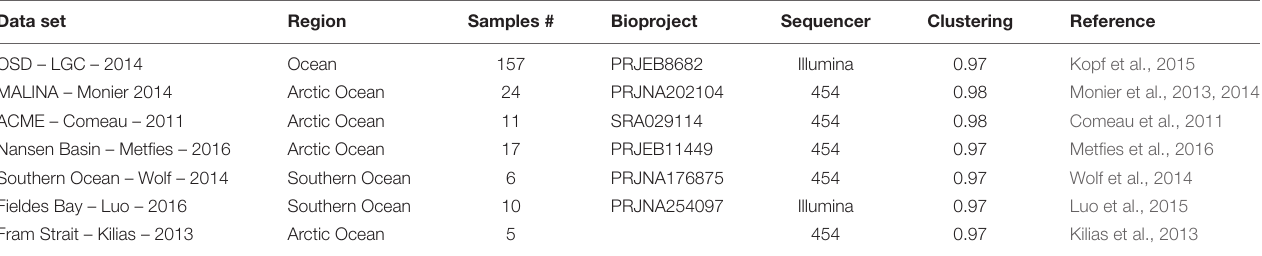
TABLE 2 | List of metabarcoding studies using the V4 region of the 18S rRNA genes that have been used for the phylogenetic ( Figure 2 ) and the biogeography analyses ( Figures 6 , 7 ).